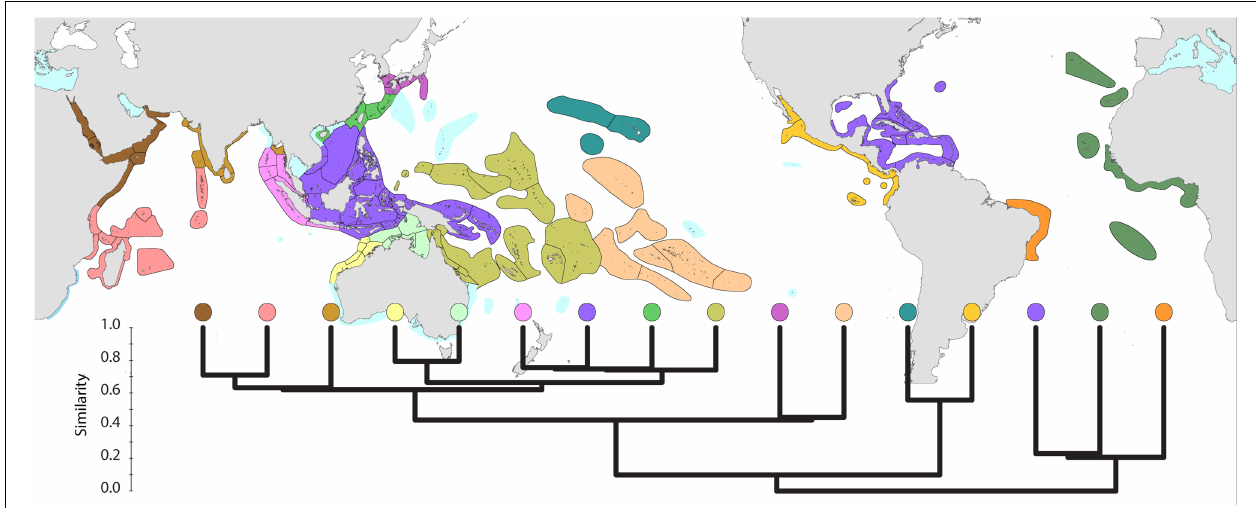
diagrams below and (b) that the similarity scale indicates the position of nodes only. Each tine above these nodes represents ecoregions of matching color.